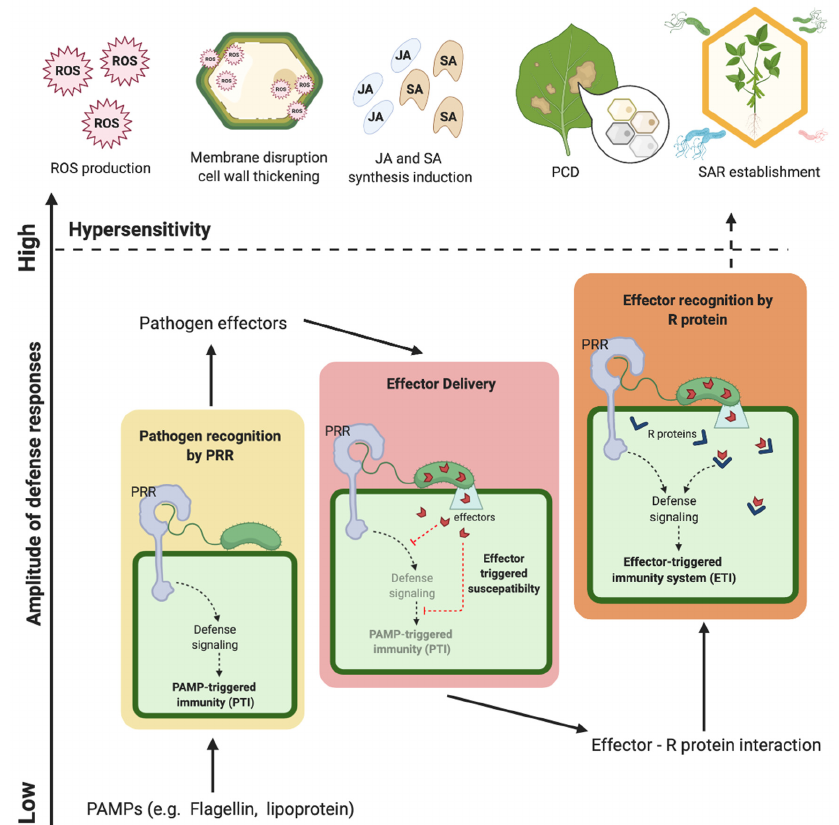
Figure 1. The overview of plant defense response. The interplay between pathogens, PTI